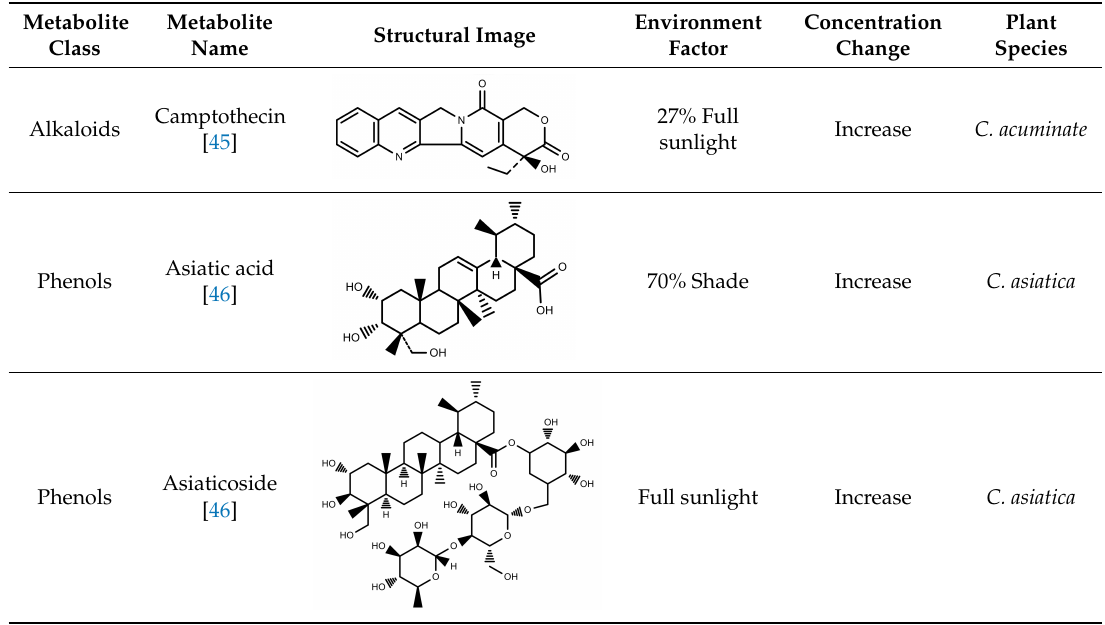
Table 2. Light intensity change on the content of various plant